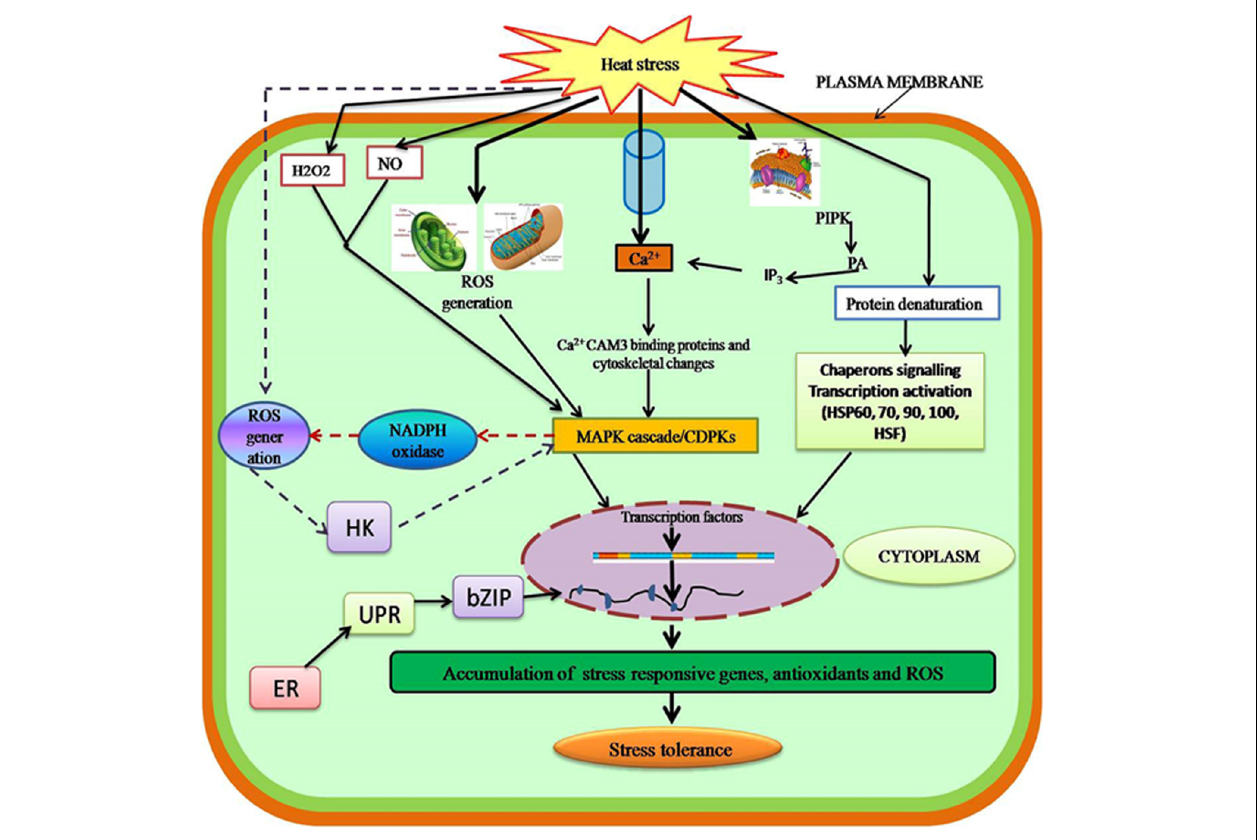
FIGURE 2 | Sensing and signaling in plants in response to heat stress. Heat stress affects the plasma membrane to activate calcium channels, which induces Ca 2 + influx and activates the heat shock response. Thus, the MAPK cascade leads to gene expression. Secondary signals such as ROS, H 2 O 2 , NO, and ABA lead to stress tolerance. CaM3, calmodulin; HSFs, heat shock factors; CDPKs, calcium-dependent protein kinases; MAPKs, mitogen-activated protein kinases; ROS, reactive oxygen species; NO, nitric oxide; HK, histidine kinase; UPR, unfolded protein response; ER-UPR, endoplasmic reticulum unfolded proteins; Cyt-UPR, cytosolic unfolded